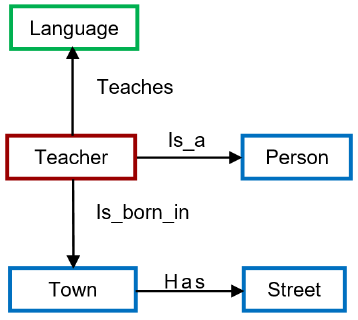
Fig. 5: Graph DB-schema 2.